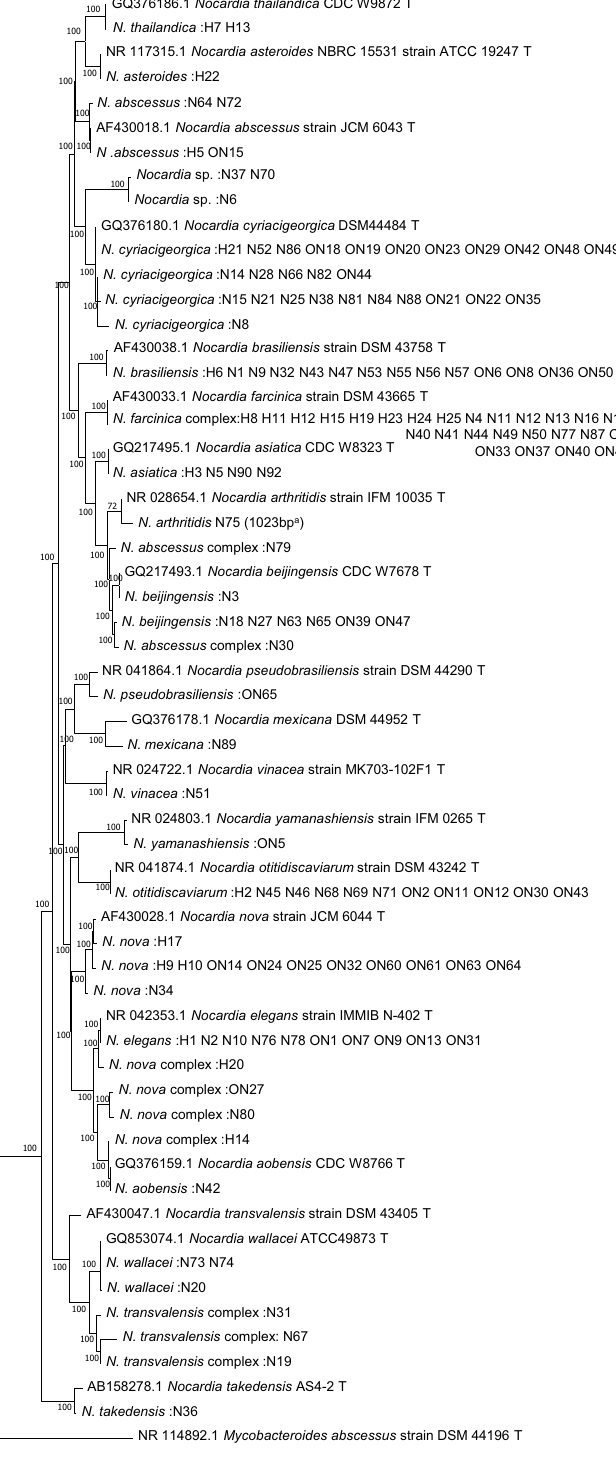
Figure 1. 16S rRNA sequence-based phylogenetic tree of clinical isolates of Nocardia with those of closely related species. The evolutionary history was inferred using the Neighbor-Joining method 16 . The optimal tree is shown. The tree is drawn to scale, with branch lengths in the same units as those of the evolutionary distances used to infer the phylogenetic tree. The evolutionary distances were computed using the Maximum Composite Likelihood method 17 and are in the units of the number of base substitutions per site. The proportion of sites where at least 1 unambiguous base is present in at least 1 sequence for each descendent clade is shown next to each internal node in the tree. This analysis involved 59 nucleotide sequences. Codon positions included were 1st + 2nd + 3rd + Noncoding. All ambiguous positions were removed for each sequence pair (pairwise deletion option). There were a total of 1405 positions in the final dataset. Evolutionary analyses were conducted in MEGA X 18 . a The read length of N75 strain was 1023 bp with a good quality